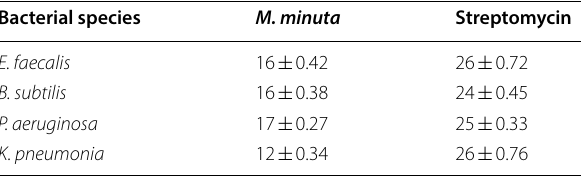
Table 3 Antibacterial activity (zone of inhibition, mm) of M. minuta leaves